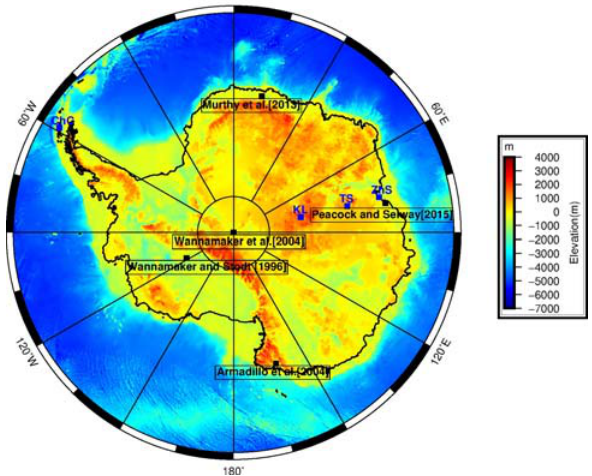
Figure 1. Topographic map of Antarctic.